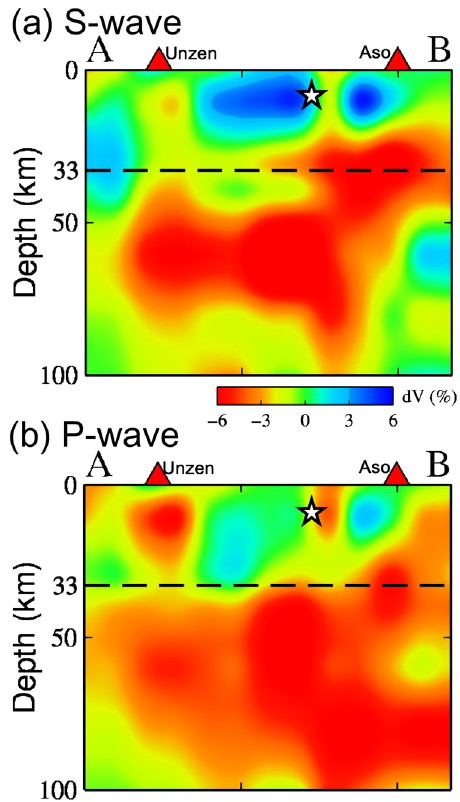
Fig. 3 Vertical cross-section of seismic tomography along the pro fi le A-B in Fig. 1. The colors show perturbations of a S-wave velocity (V S ) and b P-wave velocity (V P ) relative to the average velocity at each depth. The scale of velocity perturbations (in %) is shown below ( a ). The star symbol denotes hypocenter of the 2016 Kumamoto earthquake (M7.3). Red triangles denote locations of Unzen and Aso volcanoes. The black dashed line denotes the Moho